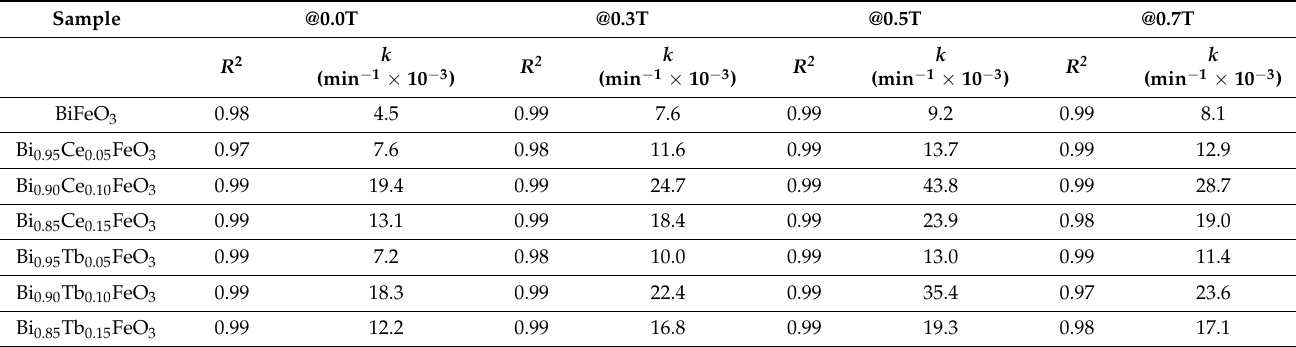
Figure 7. Photodegradation kinetics of Bi 1 − x R x FeO 3 (R = Ce, Tb; x = 0.00, 0.05, 0.10 and 0.15) nanostructures at ( a ) 0.0T ( b ) 0.3T ( c ) 0.5T and ( d ) 0.7T of MF. Table 2. First-order reaction rate constants ( k ) at different magnetic fields for BFO: RE nanostructures.